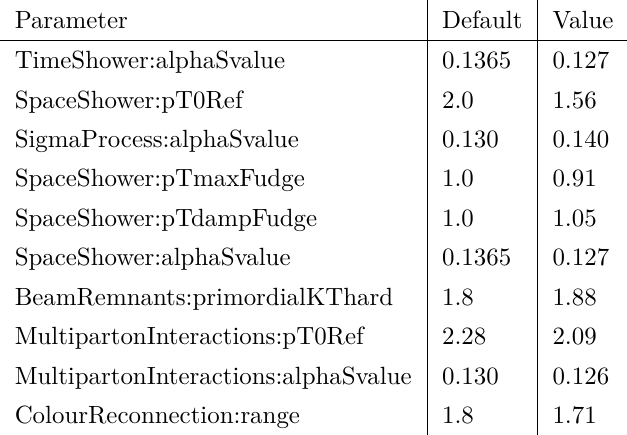
Table 4 . This table lists the Pythia 8 parameters changed from their Monash Tune default val- ues